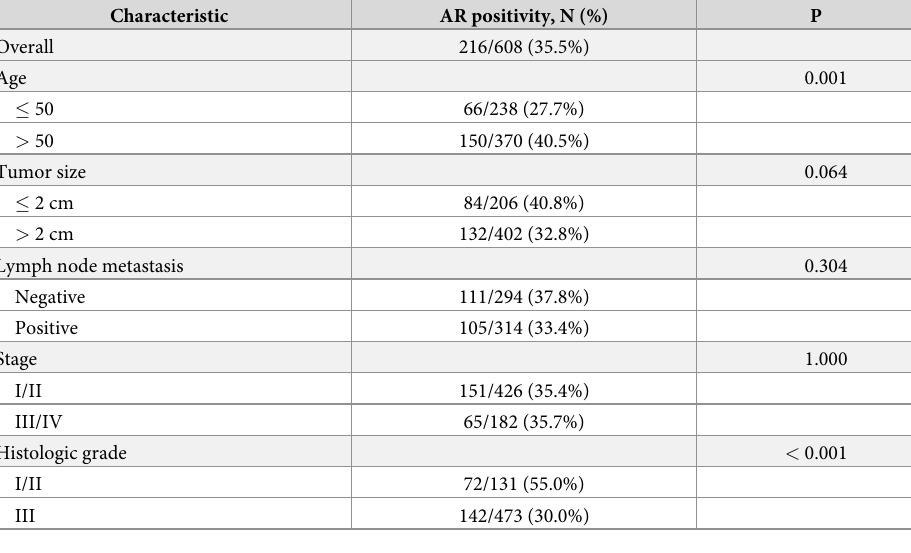
Table 2. Androgen receptor expression according to clinicopathologic characteristics.